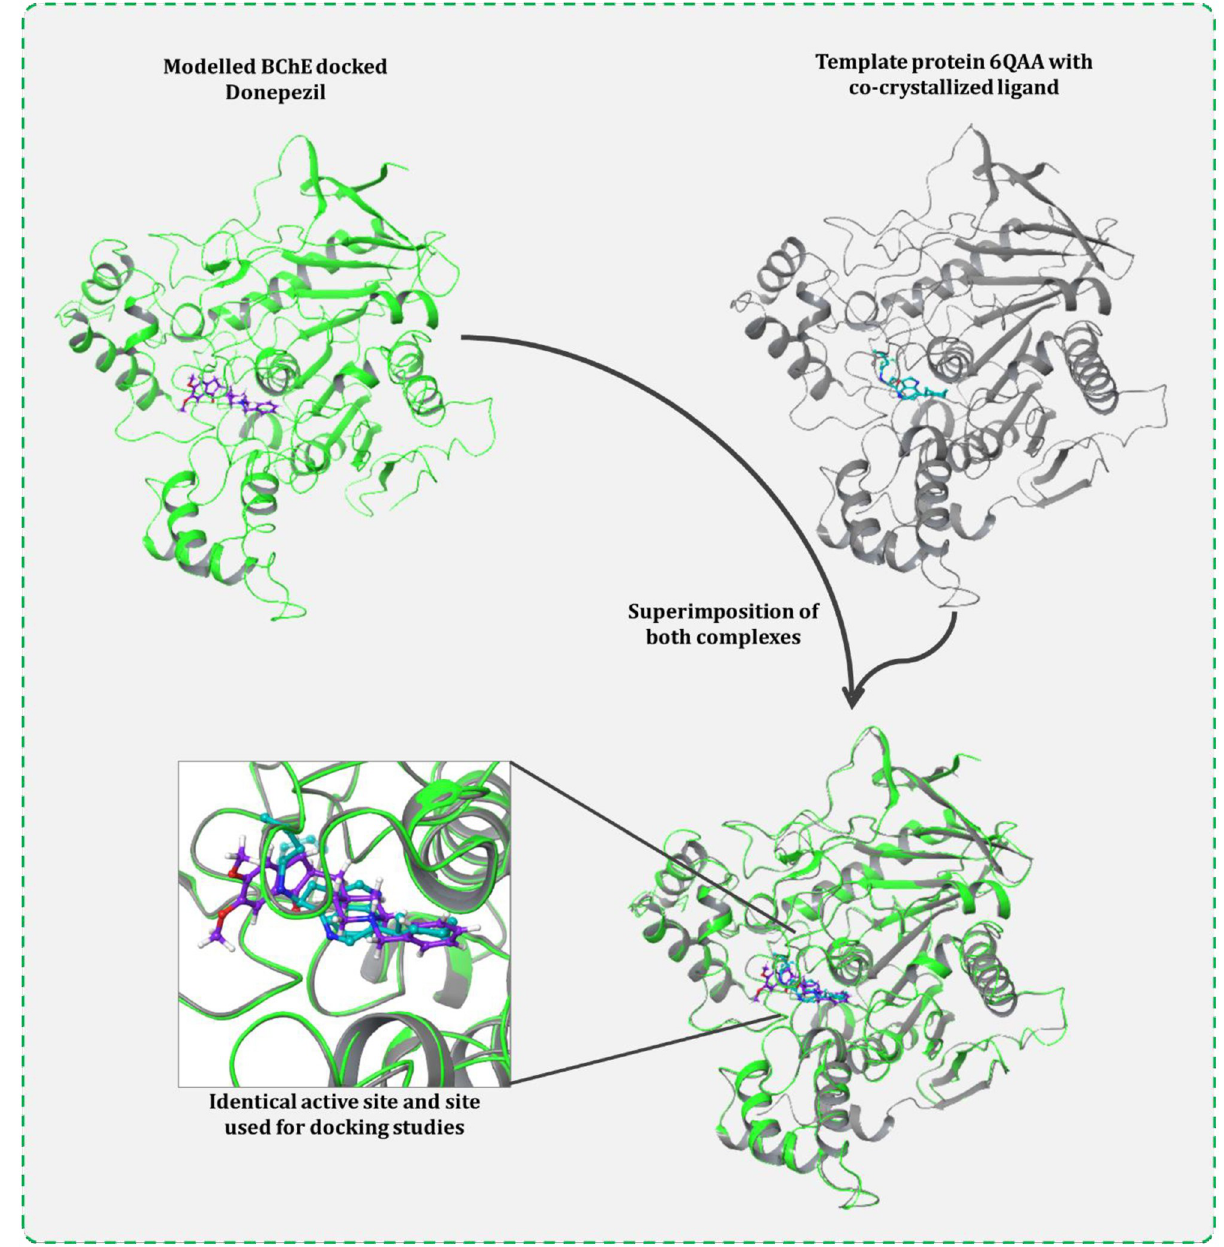
Fig 3. Validation of correct active site coordinated for docking, proved by identical binding of Donepezil with modelled BChE to that of native ligand of template protein (PDB id 6QAA). Superimposing both the protein, the active sites also get super imposed, and the respective ligand of proteins also gets superimposed at identical locus validating the coordinates of docking used for modelled BChE is apt.